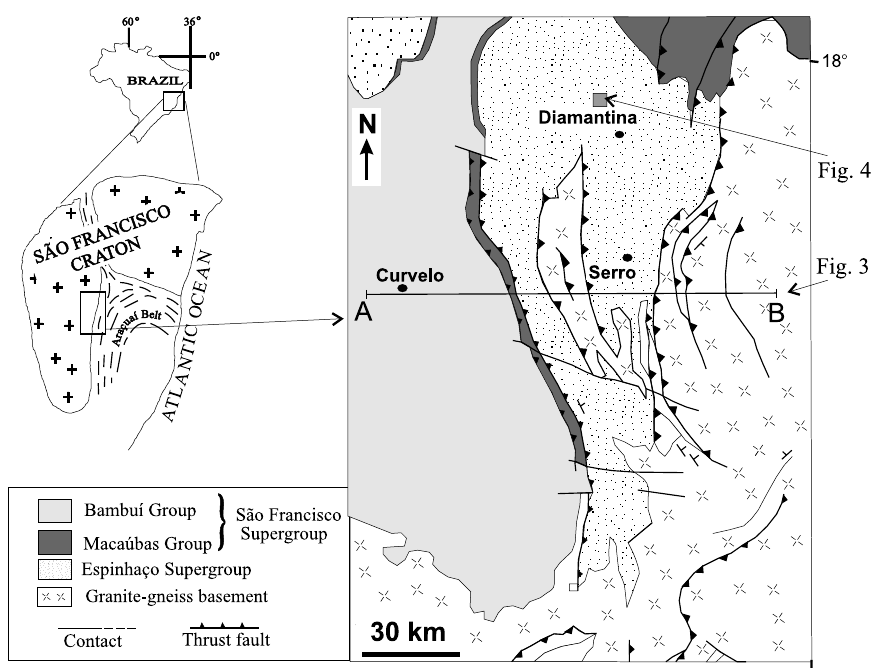
Fig. 1 – Simplified geologic-structural map of the southern Serra do Espinhaço and its setting at the São Francisco craton (modified from Schobbenhaus et al. 1984 and T.M. Dussin, unpublished data).